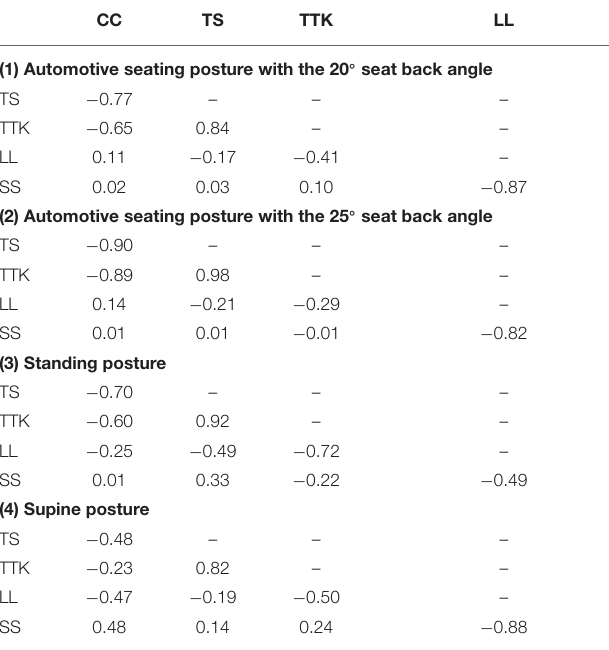
TABLE 3 | Pearson product–moment correlation coefficient R between the spinal segmental